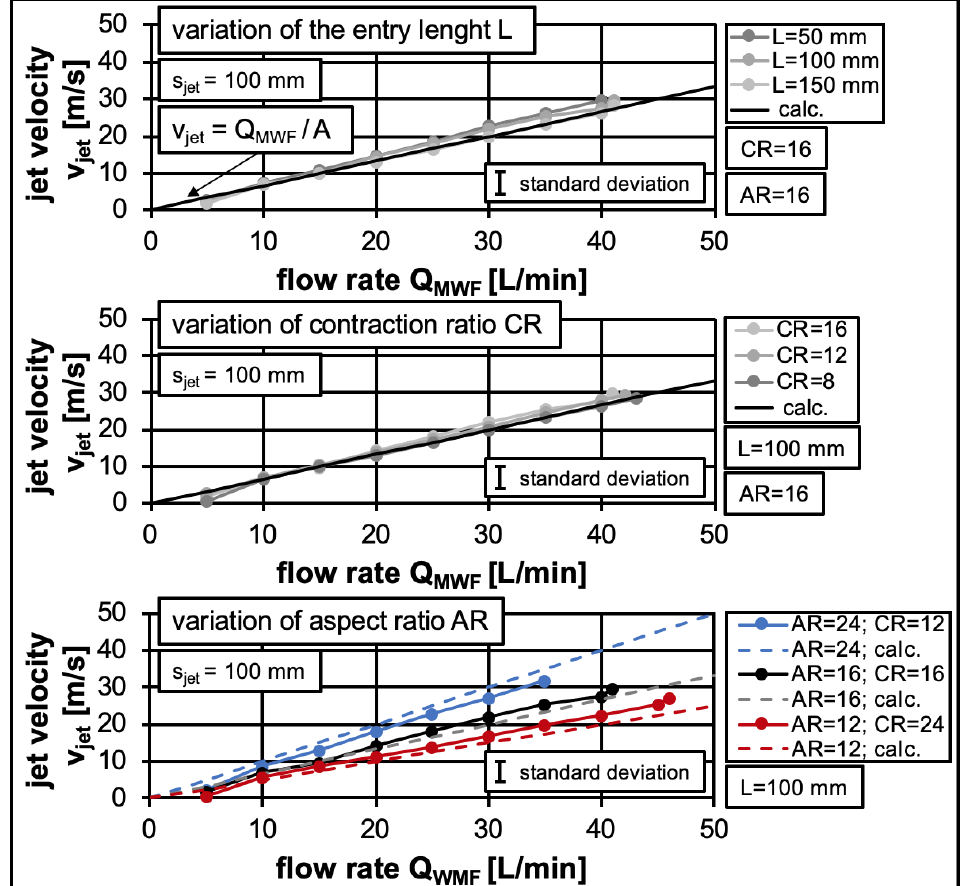
Figure 11. Jet velocity at the distance of L = 100 mm over the flow rate with variation of the entry length, contraction ratio, and aspect ratio.